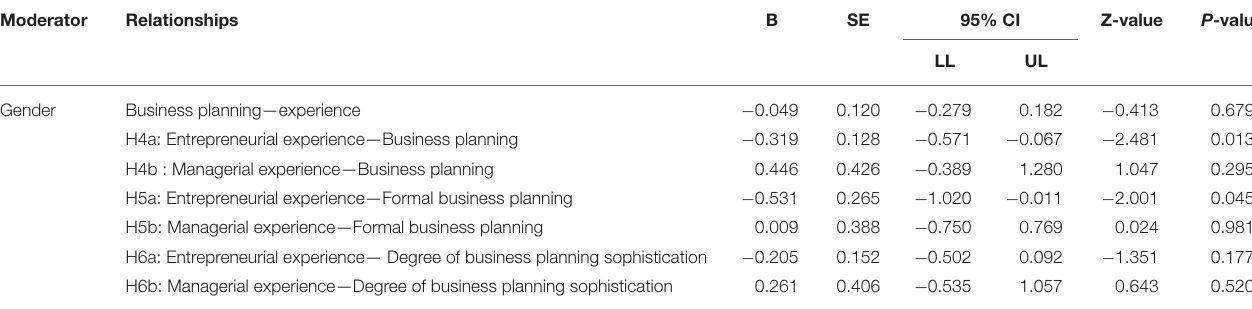
TABLE 3 | Moderating effect of gender variables of business plan-experience relationships. Moderator Relationships